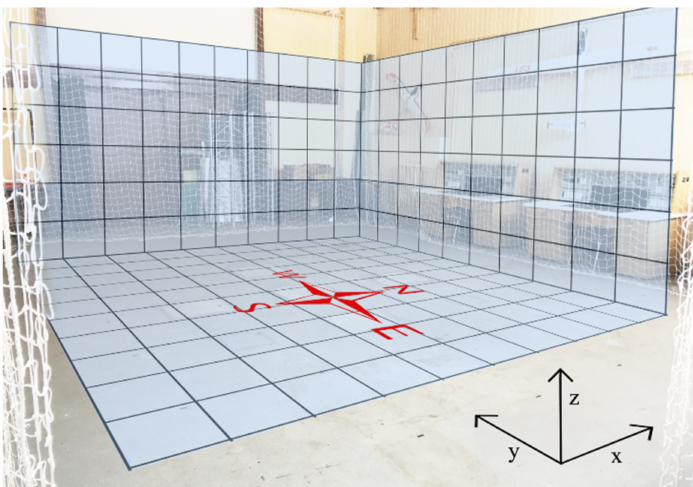
Figure 9. The measurement location—the Hall for UAS (Unmanned Aerial System)